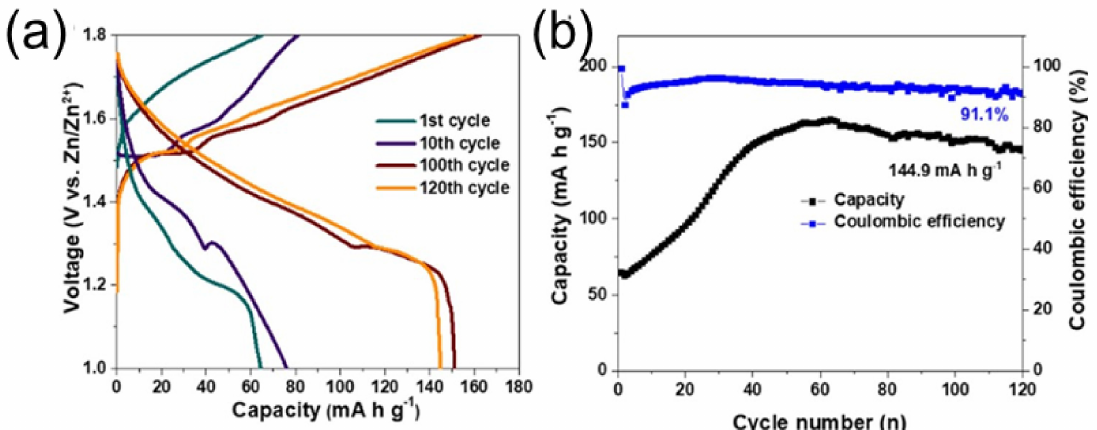
Figure 13. ( a ) Cycling performance of the transparent unstrained battery at a current density of 1 C. ( b ) GCD profiles of the transparent unstrained battery at the 1st, 10th, 100th, and 120th cycles at a current density of 1 C (=308 mA h g − 1 ). Reprinted with permission from Ref. [100]. Copyright 2021 American Chemical Society.